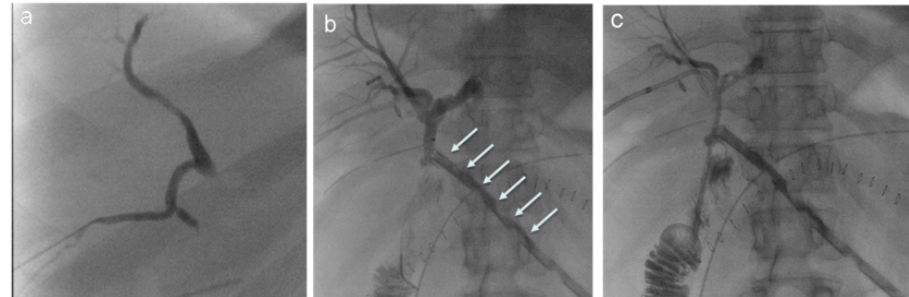
Figure 3. Biliary drainage using a right intercostal approach. ( a ) PTC performed through a puncture of a peripheral biliary duct of segment 6 in a patient with a biliary leak after pancreatic surgery. ( b ) PTC confirms the presence of a large biliary leak with a full opacification of the surgical drainage (arrows). ( c ) Using the same peripheral, right approach, an internal–external biliary drainage with extreme in the post-anastomotic jejunal loop is placed.